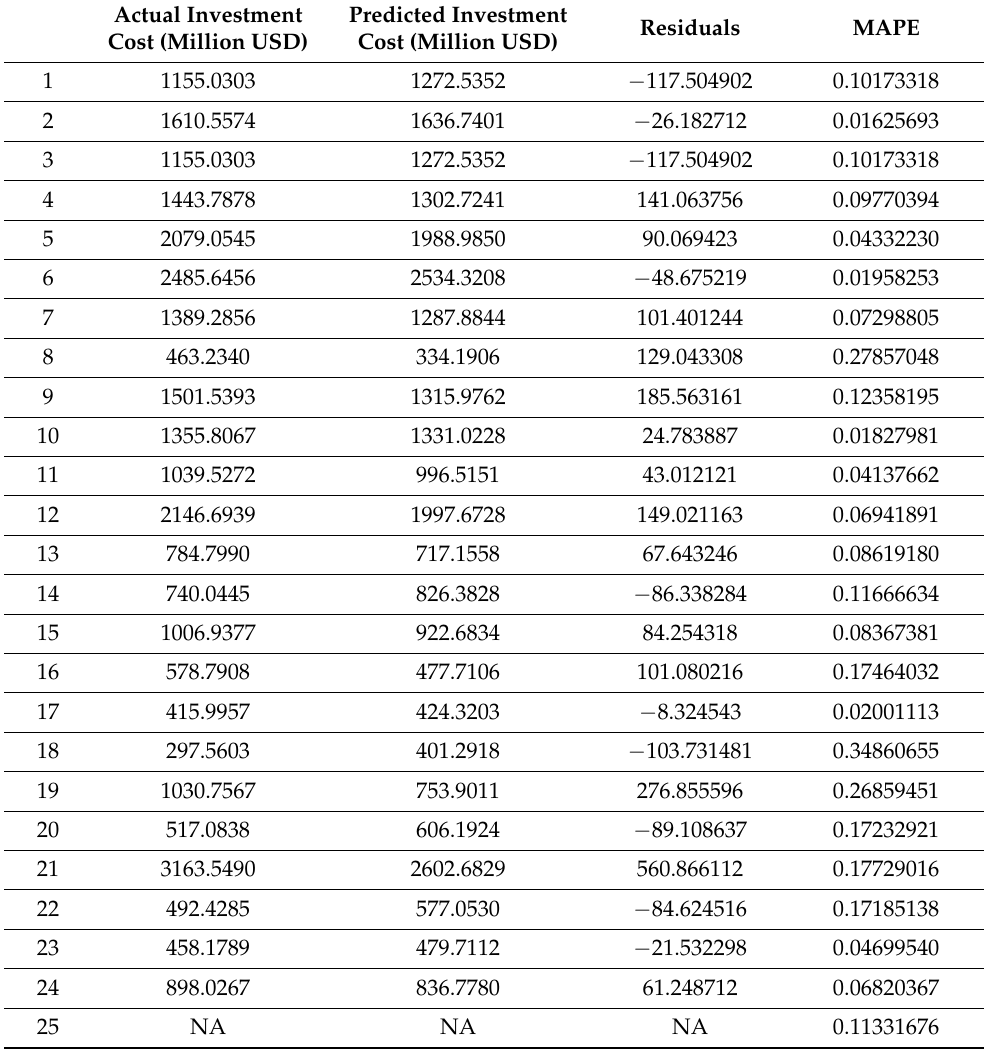
Table 3. Validation of multiple linear regression model 28 using mean absolute percentage